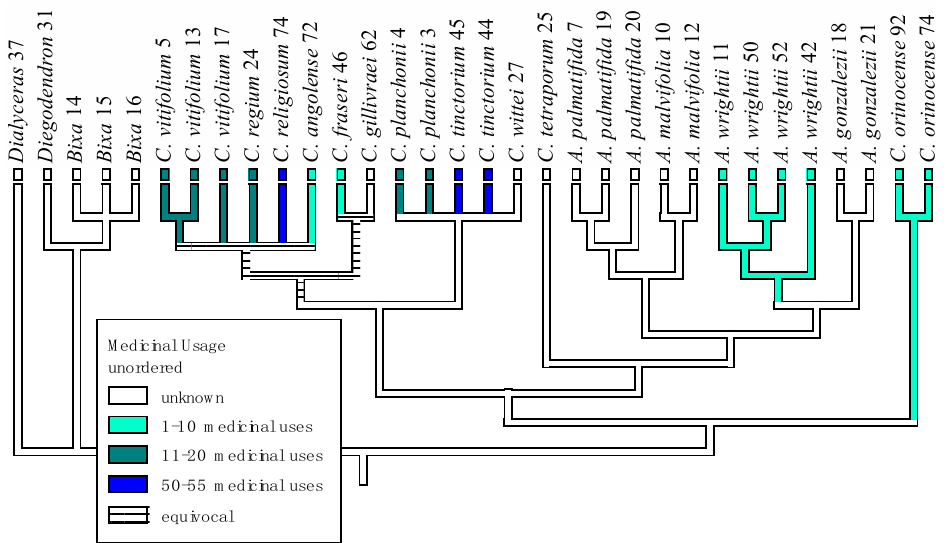
Figure 11. Number of medicinal uses of each species mapped (as unordered characters) onto the Bayesian inference phylogeny of Cochlospermaceae of the combined nuclear (ITS) and plastid ( trnG and trnL-F ) regions from Johnson-Fulton and Watson [35].